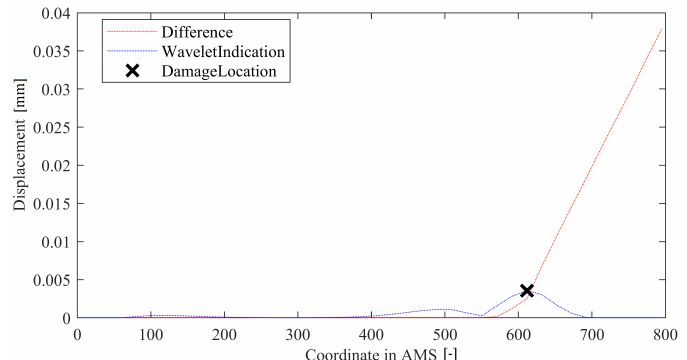
Figure 9. Example of operation of the WV